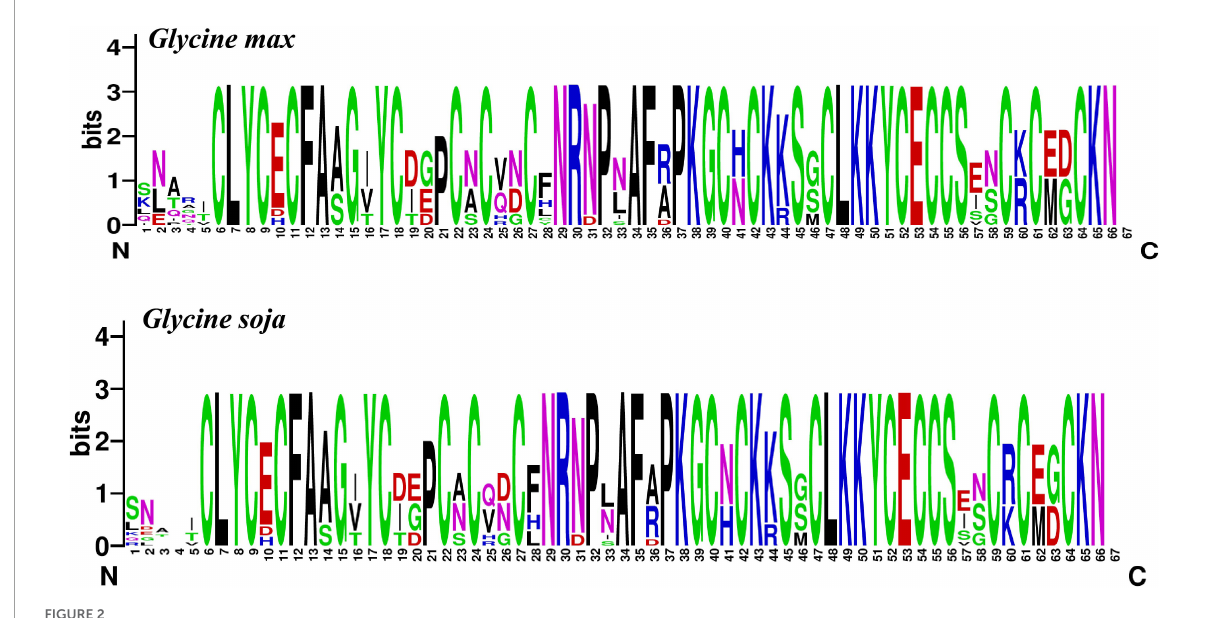
FIGURE2 Sequence logo of GmCPP and GsCPP. Amino acid residues shared by two plant species are highly conserved. Each black letter showed the conserved amino acids at a given